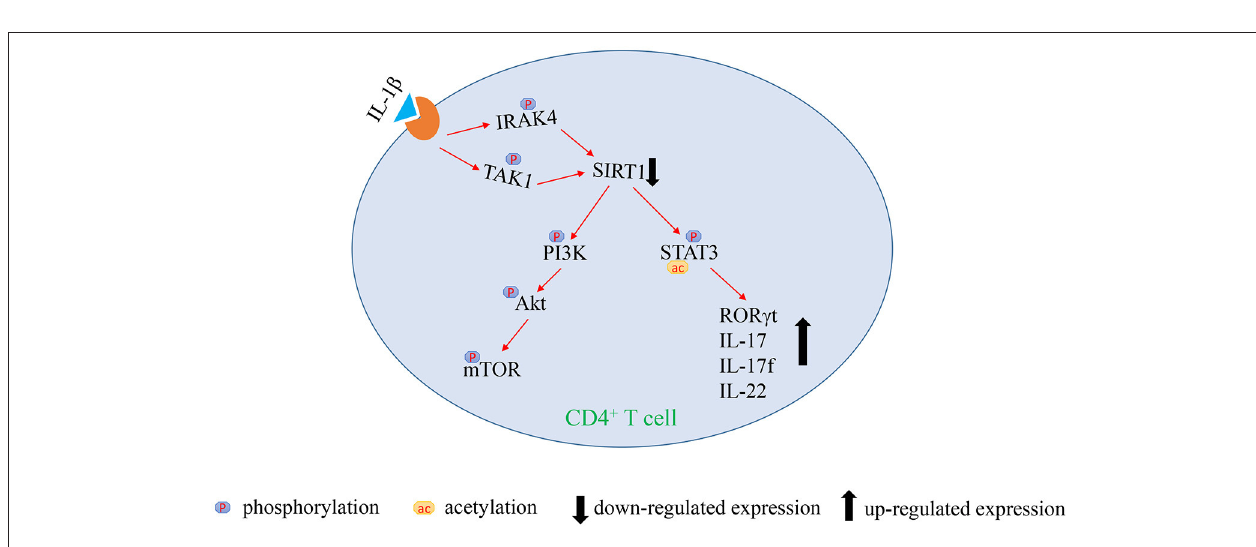
FIGURE 5 | Figure illustrating our hypothesis of signaling regulation in